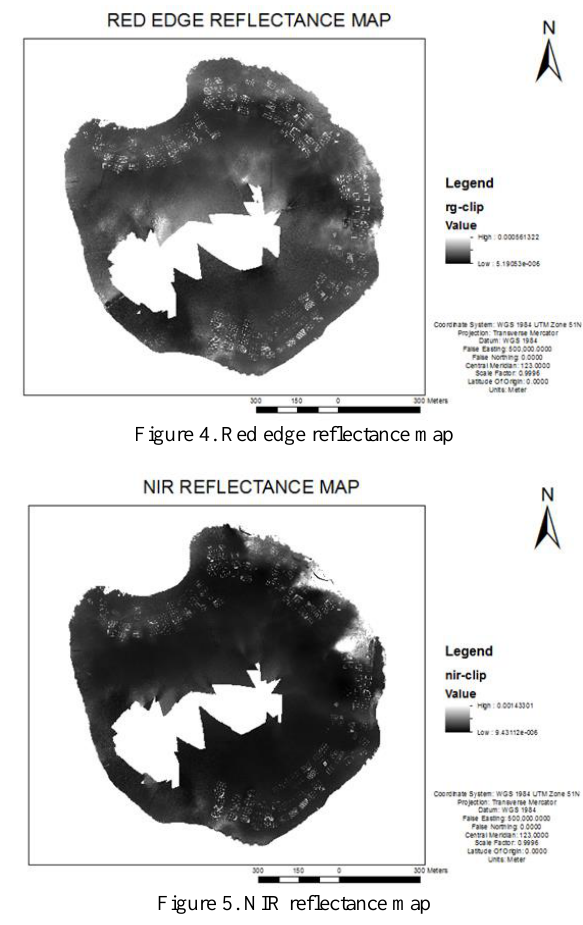
Figure 5. NIR reflectance